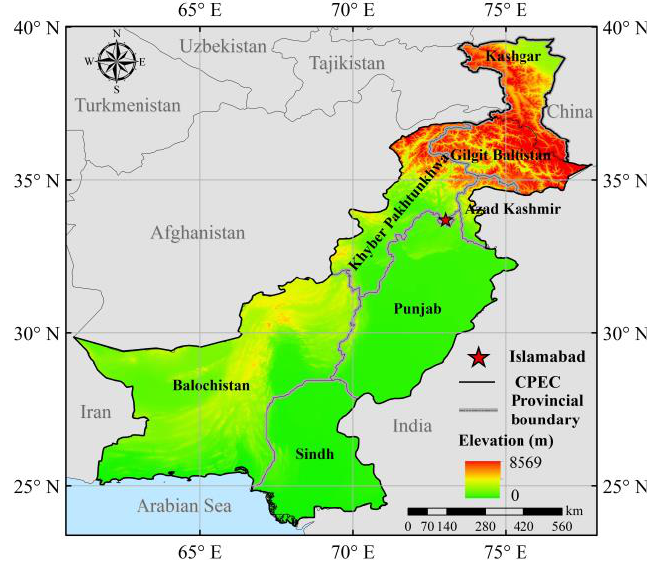
Figure 1. Sketch map of the China – Pakistan Economic Corridor (CPEC).